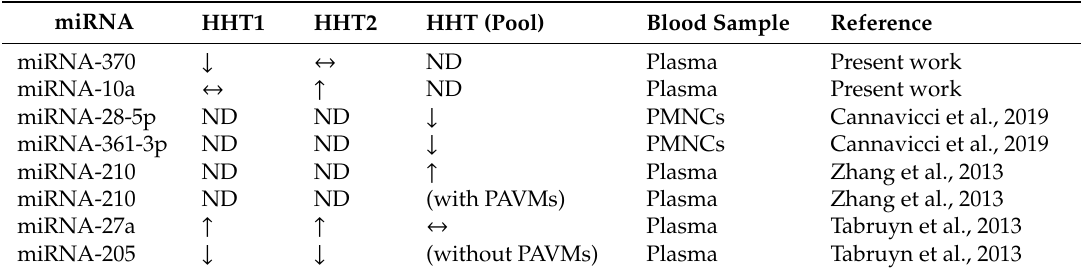
Table 2. miRNAs associated with HHT 1